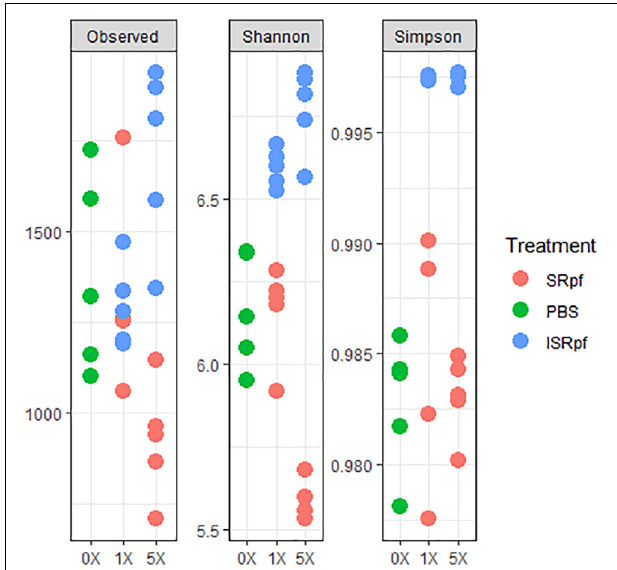
FIGURE 5 | Diversity indexes for each treatment and its concentration level. To obtain the observed number of ASVs, data was rarefied at an even depth of 24522